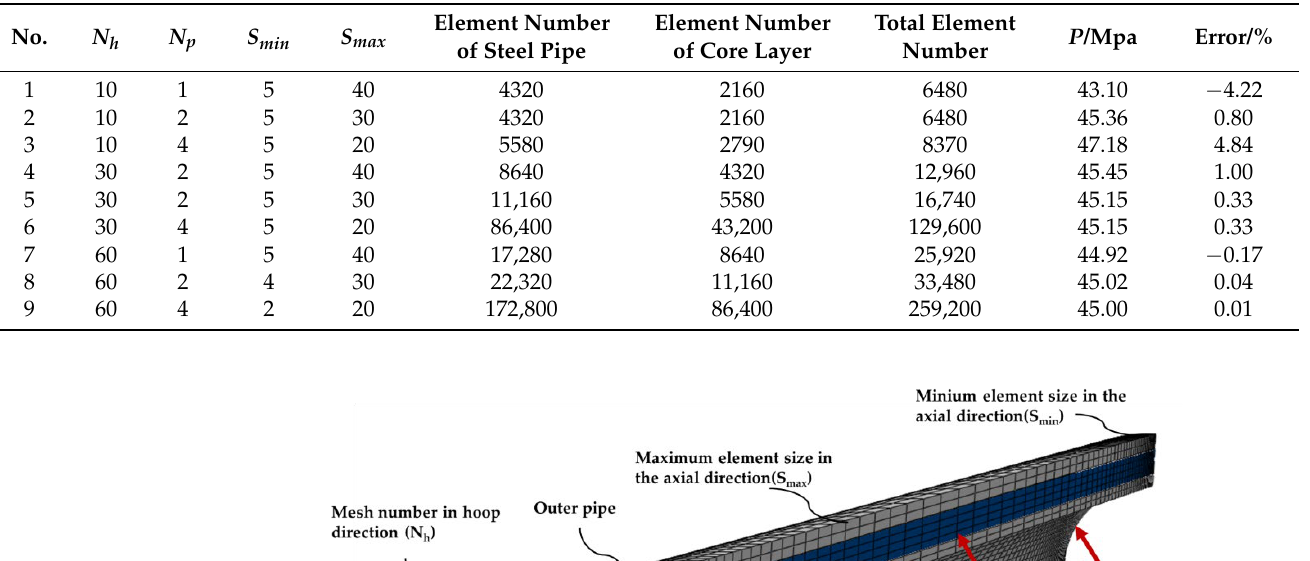
Table 5. Mesh convergence test.